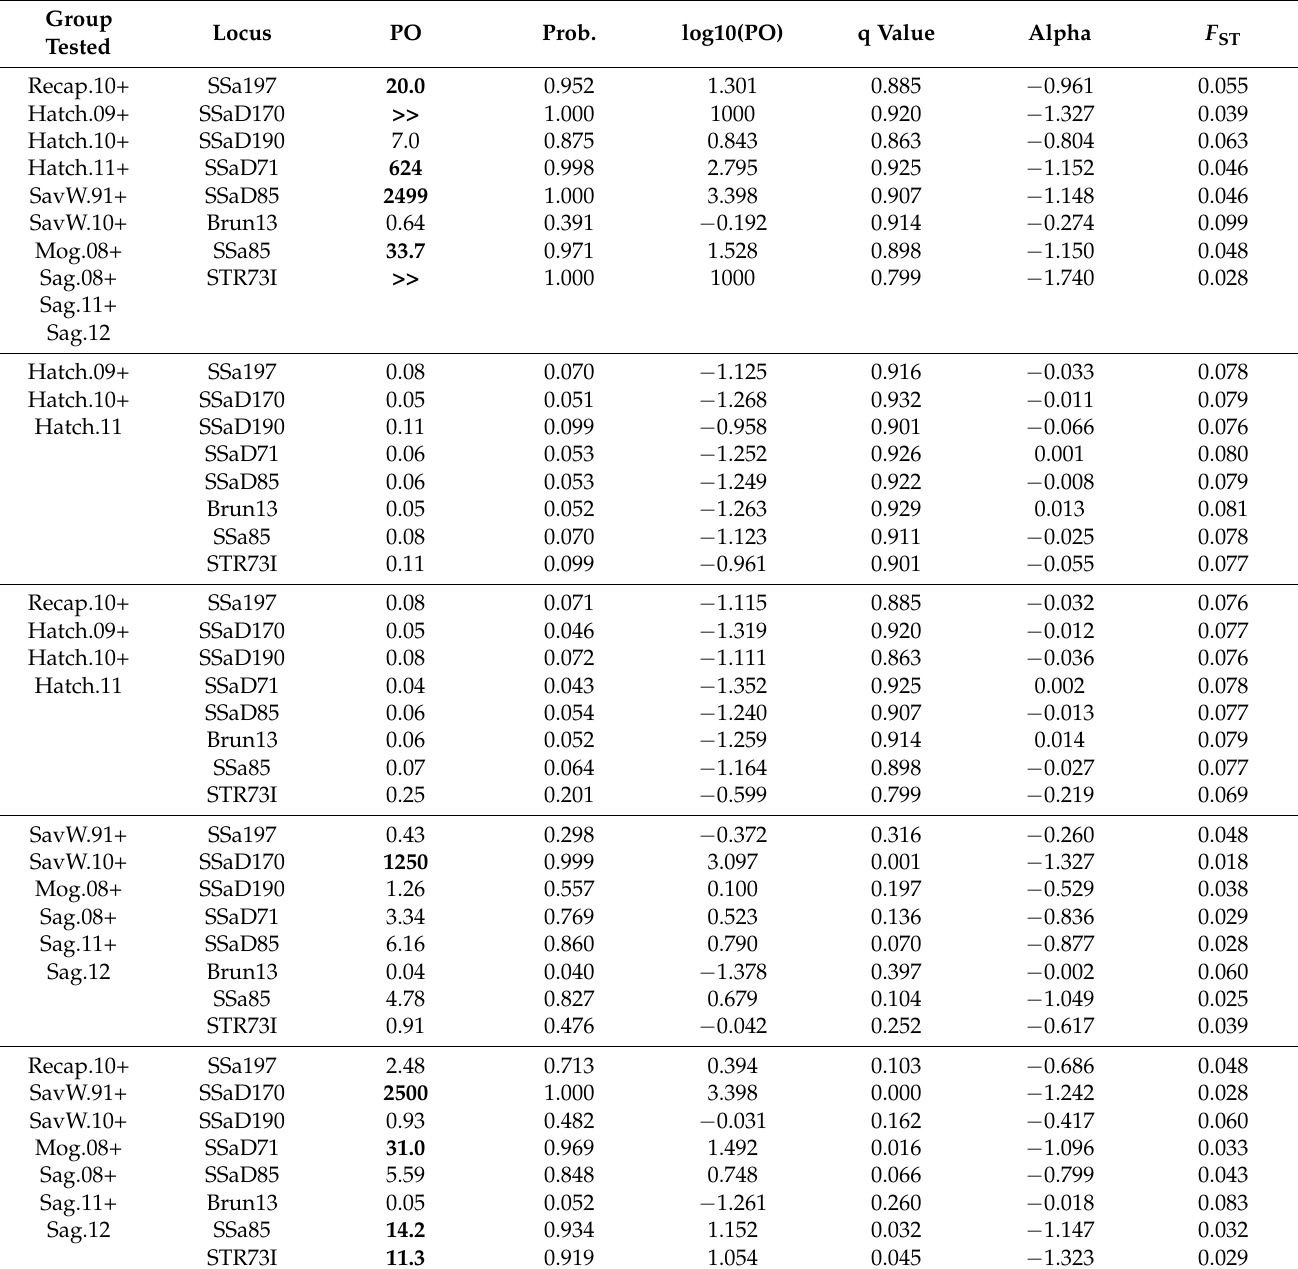
Table 3. Output table from the BayeScan analysis performed to reveal possible loci under selection. Posterior Odds (PO) is used as Bayes factors (BF) in Jefferey’s scale. Bold face indicates significant probability of